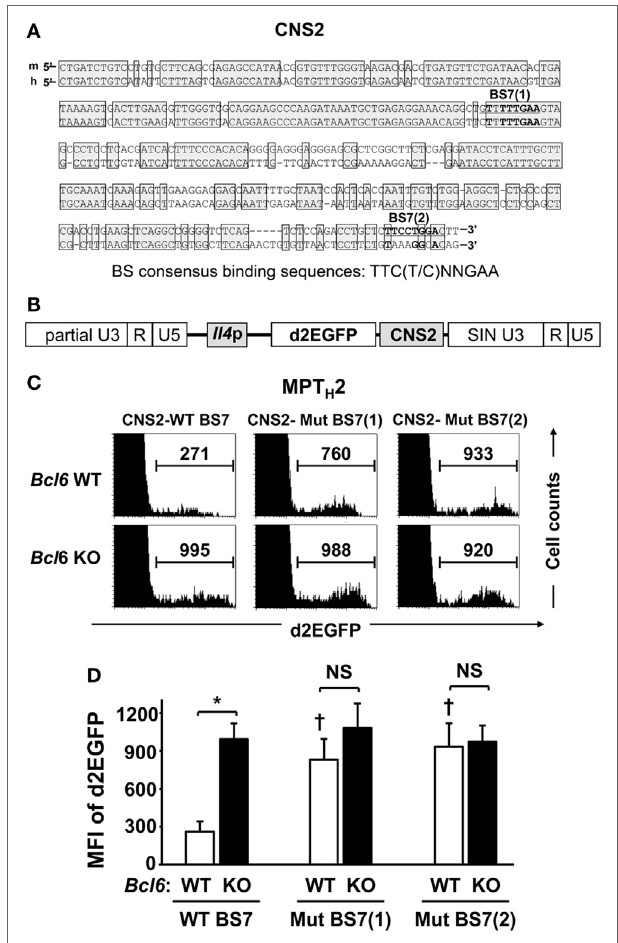
FigUre 4 | Role of Bcl6 in the CNS2 enhancer activity of MPT H 2 cells. (a) A conserved sequence (positions + 12805 to + 13151 relative to the transcription start site; Mouse Genome Informatics accession no. 96556) in the CNS2 region of mice is shown with human CNS2, including BS7 (1) and (2). Conserved sequences between mice and humans are indicated by shaded boxes. (B,c) Splenic Bcl6 -KO and Bcl6 -WT MPT cells were cultured under T H 2 conditions, and a retrovirus containing the d2EGFP reporter gene, with CNS2-WT BS7 (B) , CNS2-Mut BS7 (1), or CNS2-Mut BS7 (2), was introduced into T H 2 cells on day 2 of culture. After 7 days of culture, cells were restimulated with anti-CD3 monoclonal antibodies for 8 h and subjected to FACS analysis of the intracellular MFI of d2EGFP. (c) Histograms of FACS analysis are representative of eight to nine independent experiments. Numbers in each column represent the MFI of d2EGFP. (D) Mean values of the MFI of d2EGFP are indicated. Data are presented as the mean ± SEM ( n = 8–9). * P < 0.05, comparison between two groups is indicated; † P < 0.05, compared with CNS2-WT. Bcl6, B-cell lymphoma 6; CNS, conserved noncoding sequence; d2EGFP, d2-enhanced green fluorescent protein; FACS, fluorescence-activated cell sorting; MFI, mean